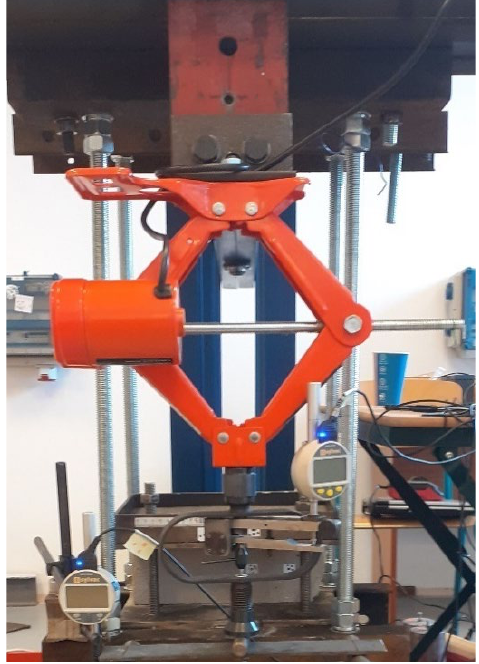
Figure 5. Mechanism used to introduce the load into the